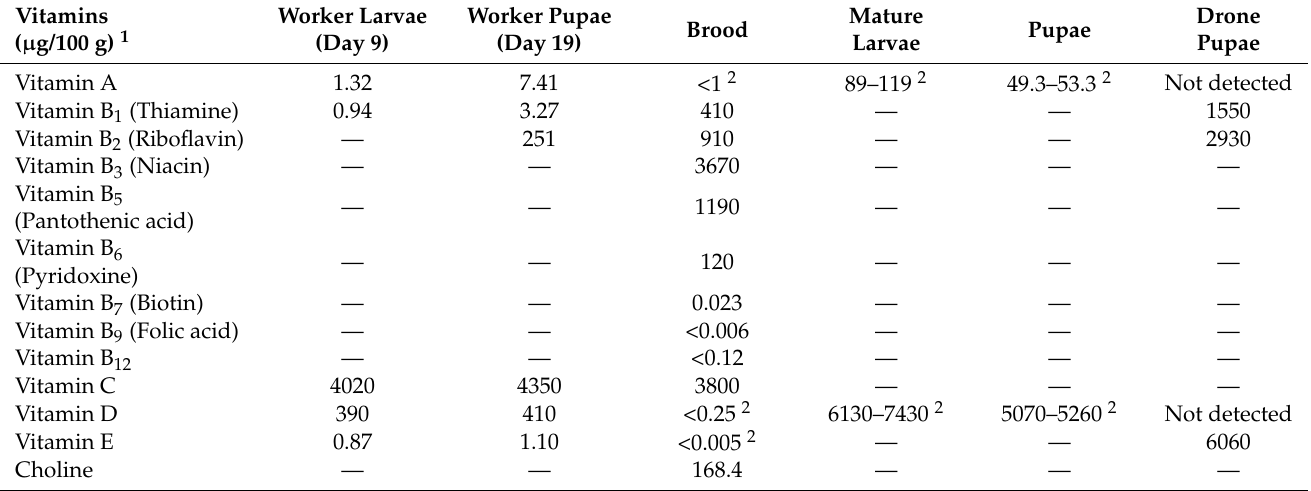
Table 7. Vitamins of Apis mellifera brood